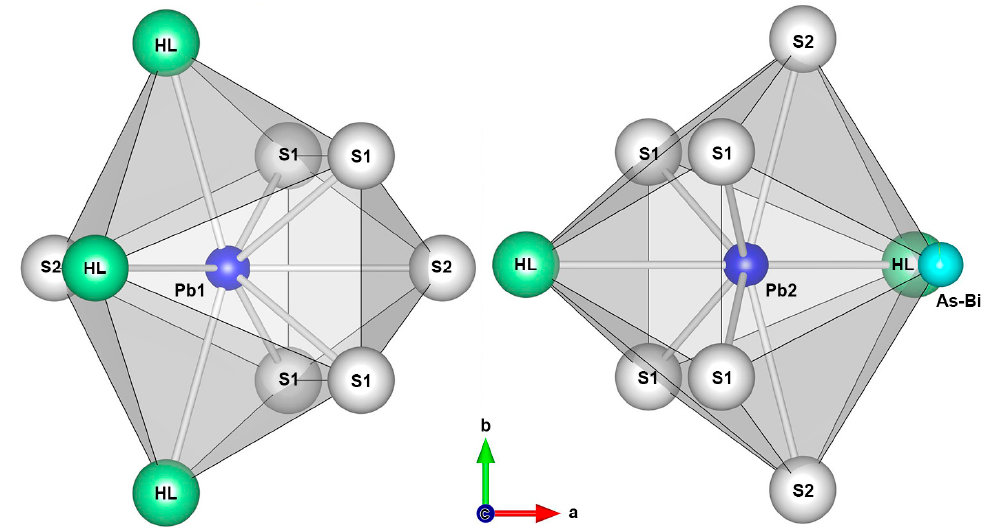
Figure 6. The heteroligand tricapped trigonal prisms around Pb1 and Pb2 in the crystal structure of mutnovskite (Zelenski et al. [35]). HL denotes the mixed halogen ligands with I–Cl–Br and S1,S2 represent mixed (S,Se). The As–Bi position is located in a ´vacant´ vertex of the Pb2 tricapped prism. Table 2. Bond distances ( 𝑅 (cid:3036)(cid:3037) ), bond weights ( 𝑤 (cid:3036)(cid:3037) ) , 𝐸𝐶𝑜𝑁 (cid:3025) , calculated charges ( 𝑄 (cid:3025) , 𝑄 (cid:3002) ) , and 𝑀𝐴𝑃𝐷 (%) for mutnovskite (Zelenski et al. [35]) in cation-centered, homoligand, and heteroligand approaches .